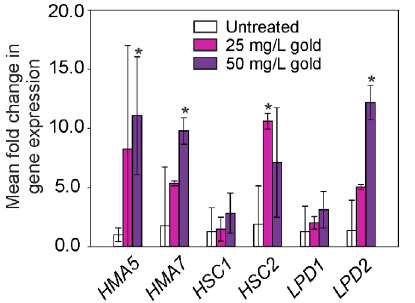
Figure 5. Comparison of qPCR and microarray gene expression levels in Arabidopsis root tissue treated with gold. Plants were grown hydroponically for six weeks then the medium was replaced with 25 mg/L gold, as K(AuCl 4 ) for 6 h, and then RNA extracted from roots for qPCR analysis. The data were normalized to the Arabidopsis ACTIN2 gene and relative fold induction calculated using the DD Ct method [36]. Results are the mean from three biological replicates 6 SD.